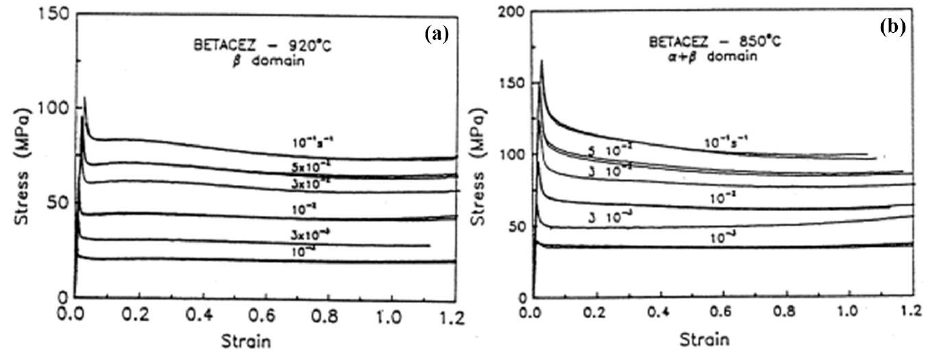
Figure 8. An illustration of the differences in hot deformation plastic flow curves for the Ti-5Al-2Sn-2Cr-4Mo-4Zr-1Fe (wt. %) alloy referred to as Beta CEZ at 920 ◦ C (super-transus) in ( a ) and at 850 ◦ C (sub-transus) in ( b ). The quantity T β is approximately 890 ◦ C for this alloy [58]. (Reprinted by permission from Materials Science and Engineering A, vol. 243, no. 1–2, I. Weiss and S. L. Semiatin, Thermomechanical processing of beta titanium Alloys—an overview, 46–65, 1998, with permission from Elsevier).